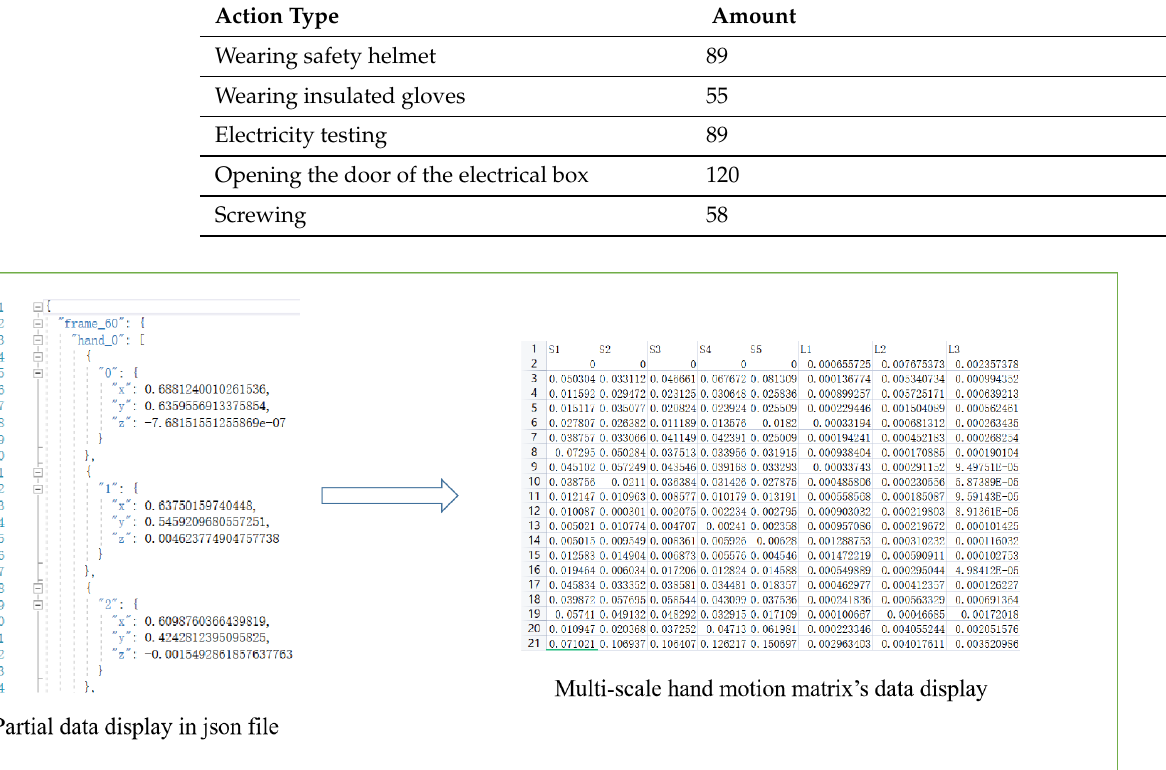
Figure 8. Action data conversion diagram.